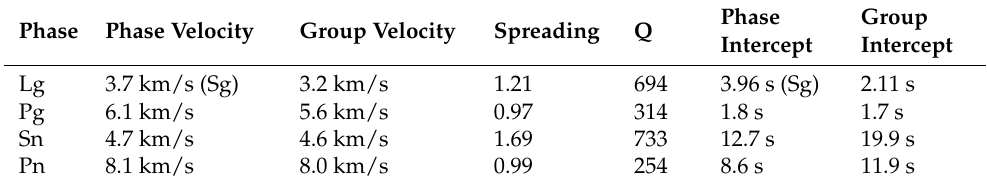
Table 2. Results from